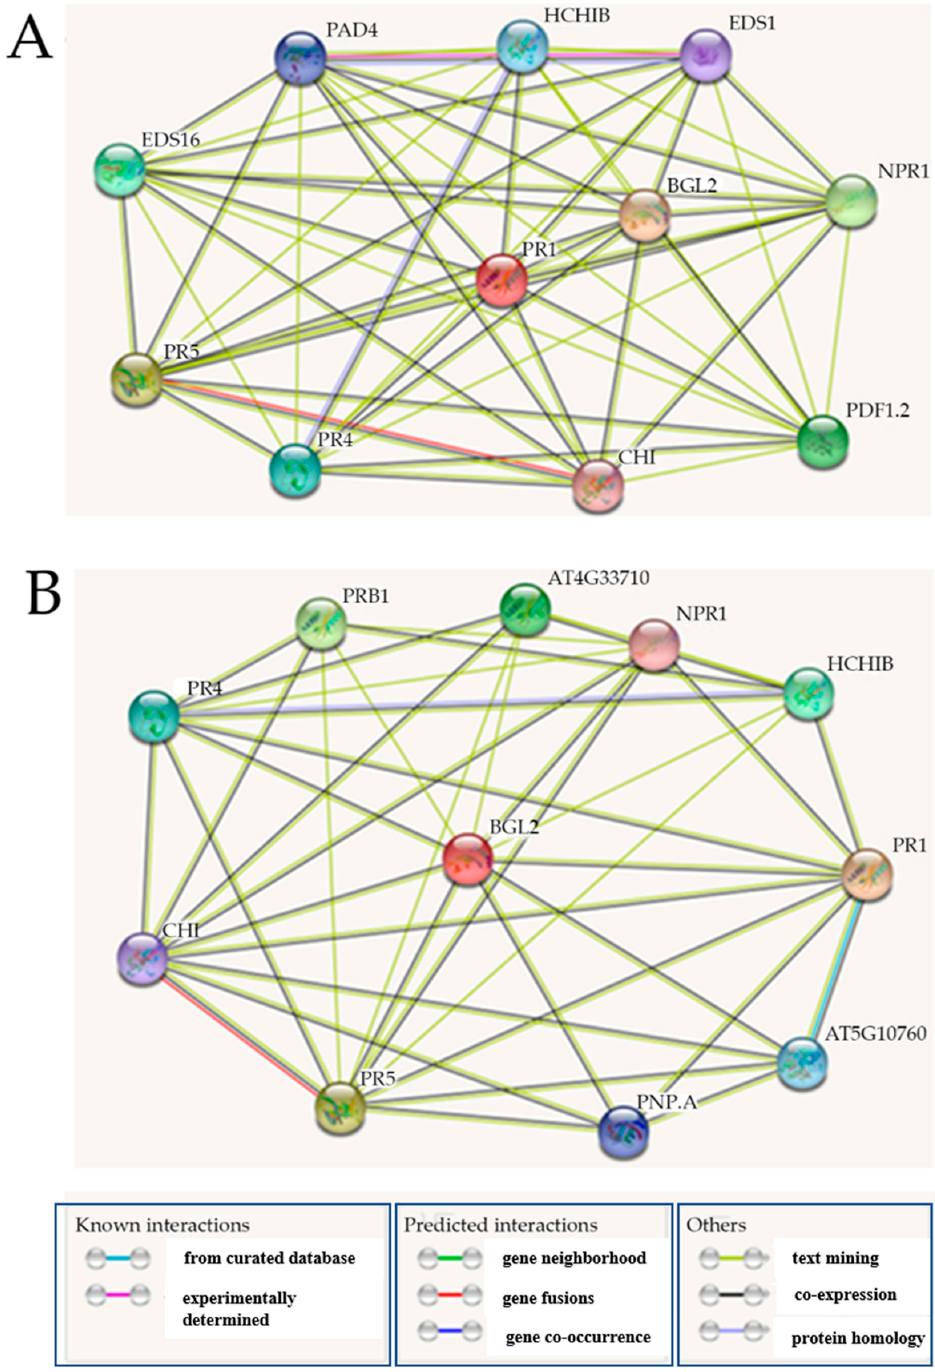
Figure 4. Prediction of the functional protein–protein interactome of selected pathogenesis-related genes. Predicted protein–protein interaction network involving the Arabidopsis ( A ) AtPR1 and ( B ) AtPR2 or BGL2 (proteins) with other pathogenesis-related protein-coding genes. The prediction was performed using the protein sequence of each target gene obtained from the Arabidopsis Information Resource (TAIR, www.arabidopsis.org (accessed on 9 October 2021)) and uploaded to STRING protein database version 11.5 (https://string-db-org/ (accessed on 9 October 2021)). Red nodes indicate the gene of interest, while other nodes represent the interactome of a different nature indicated by connecting lines. The nature of the interaction is indicated by specific line colors and the source of information (from curated databases, experimentally determined, predicted interactions, and others), as explained in the figure legend below the panel ( B